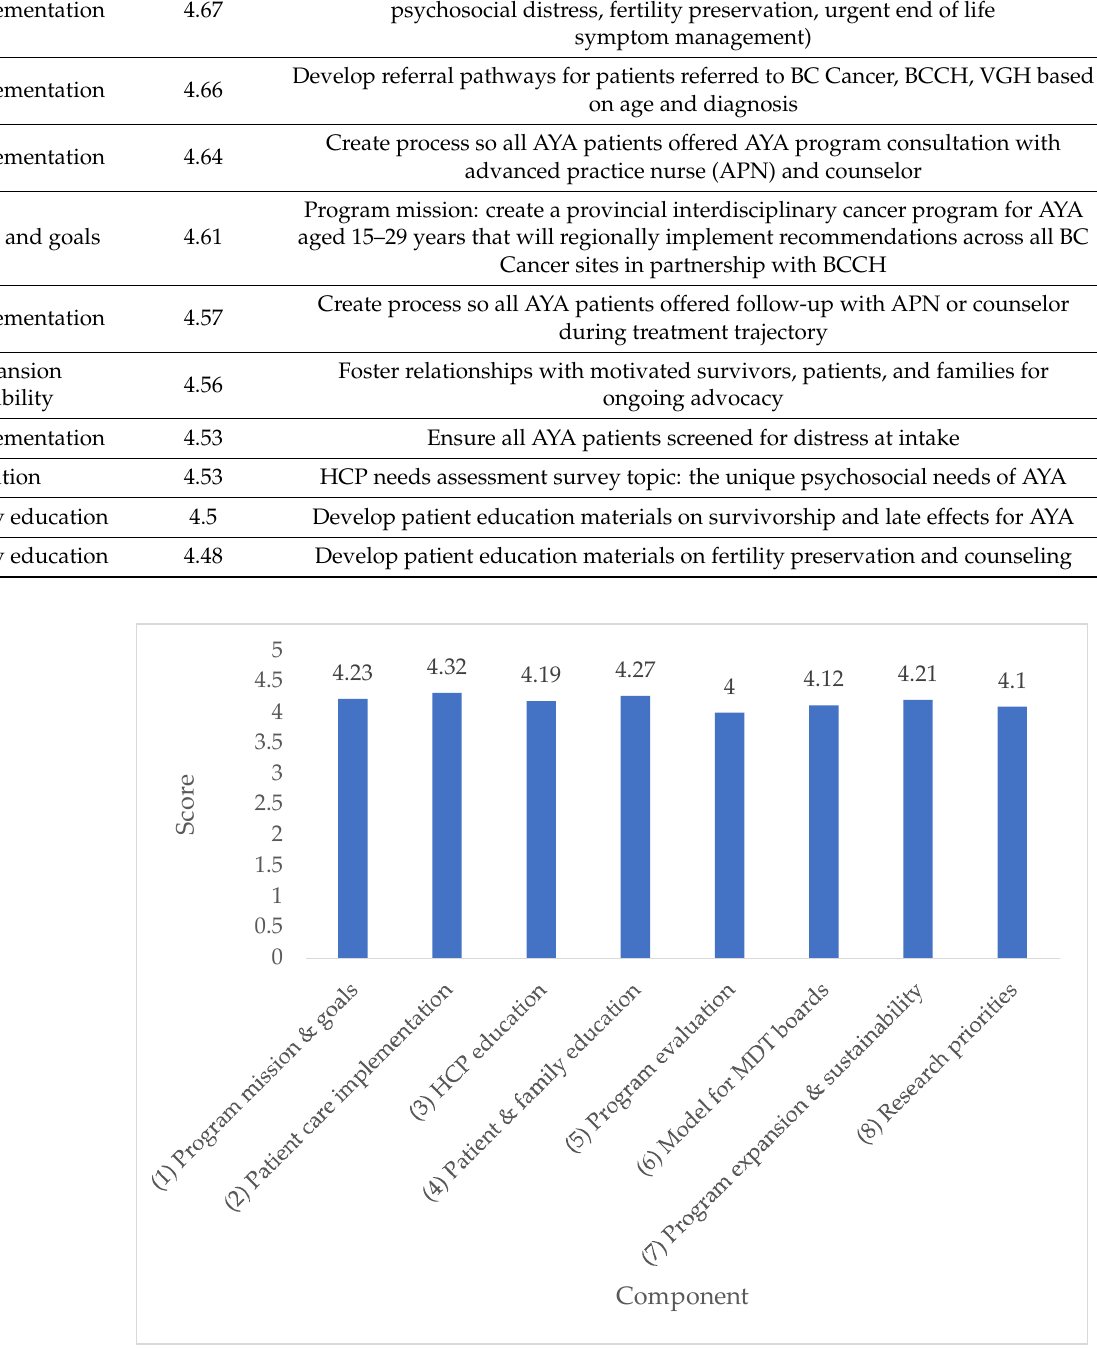
Figure 1. Average score per component.